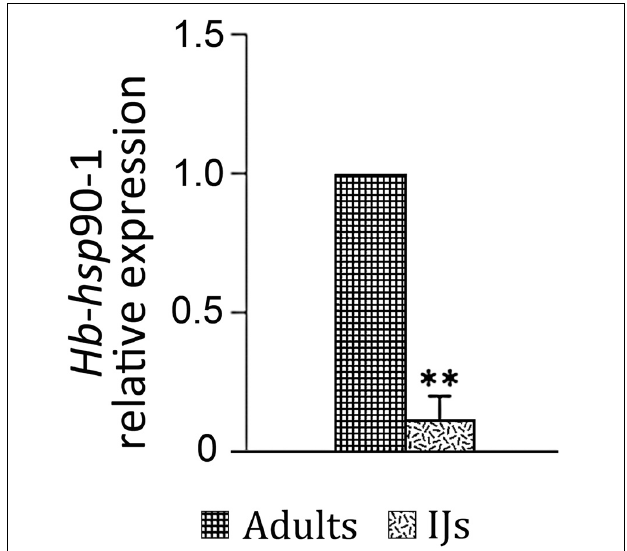
FIGURE 4 | Expression of the Hb - hsp 90-1 in Infective Juveniles (IJs) and adults. Bars indicate standard error of mean data ( n = 3). (** P < 0 . 01).